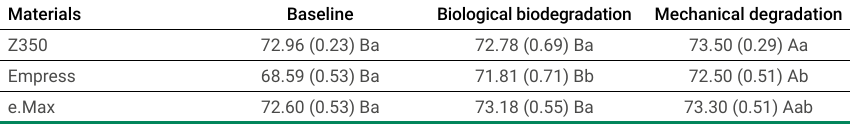
Table 5. Means (standard deviation) of lightness (L*) for the different experimental conditions.